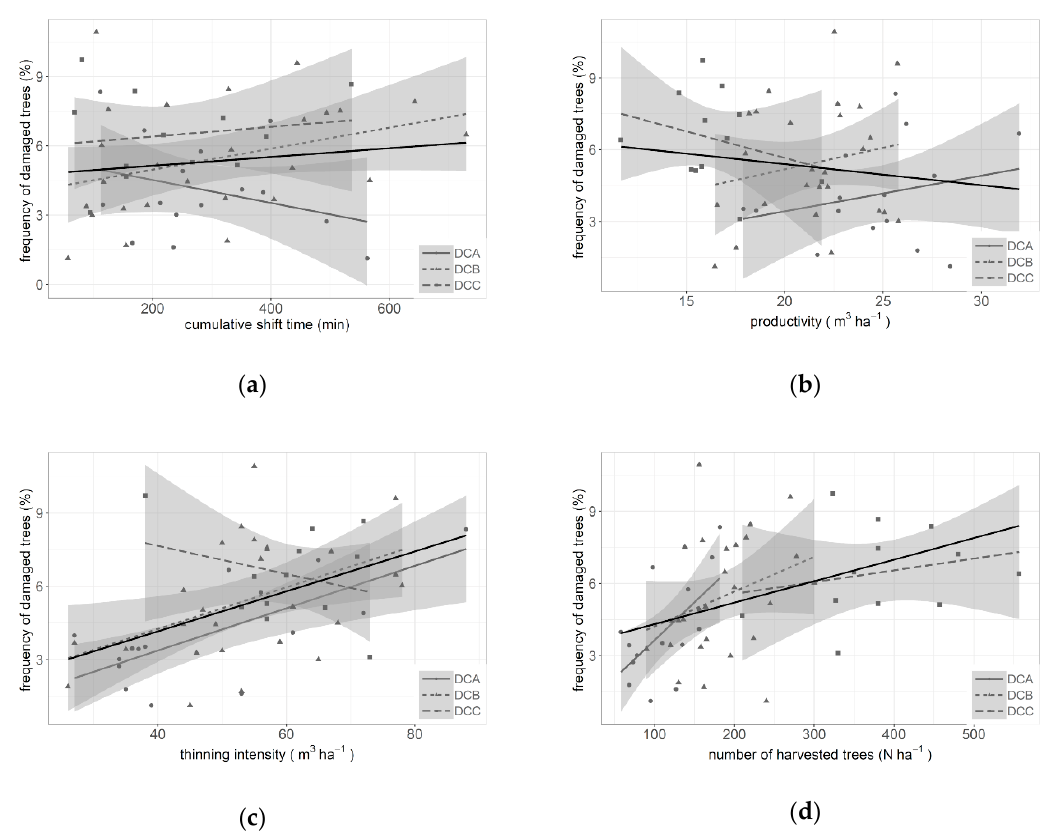
Figure 2. Percentage of damaged trees in density classes (DC) as a function of: ( a ) cumulative shift time; ( b ) productivity; ( c ) number of harvested trees; ( d ) number of extracted trees. Black curves represent mean values for all data.